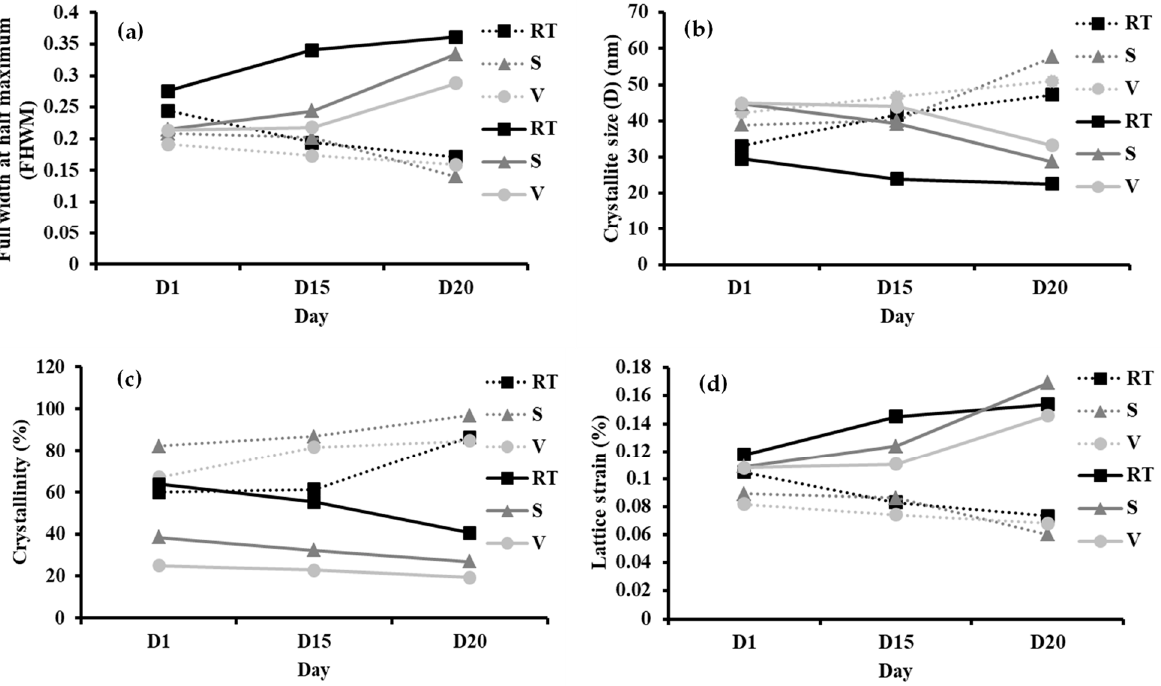
Figure 10. Parameters of: ( a ) full width at half maximum (FHWM), ( b ) crystallite size, ( c ) crystallinity and ( d ) lattice strain of I ‐ AMP ( ⸻ ) and N ‐ AMP ( ∙∙∙∙∙ ) with ■ marking RT, ▲ marking S and ● marking V.